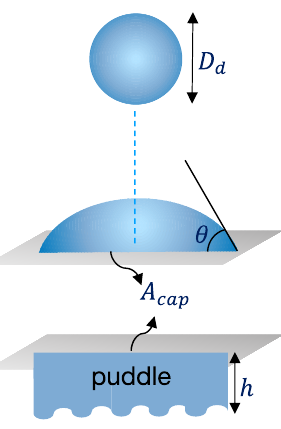
Figure 2. A schematic diagram of a droplet (with diameter, 𝐷 𝑑 and cap area, 𝐴 𝑐𝑎𝑝 ) deposition on the surface of soft PPs and the formation of a puddle (with height ℎ ).